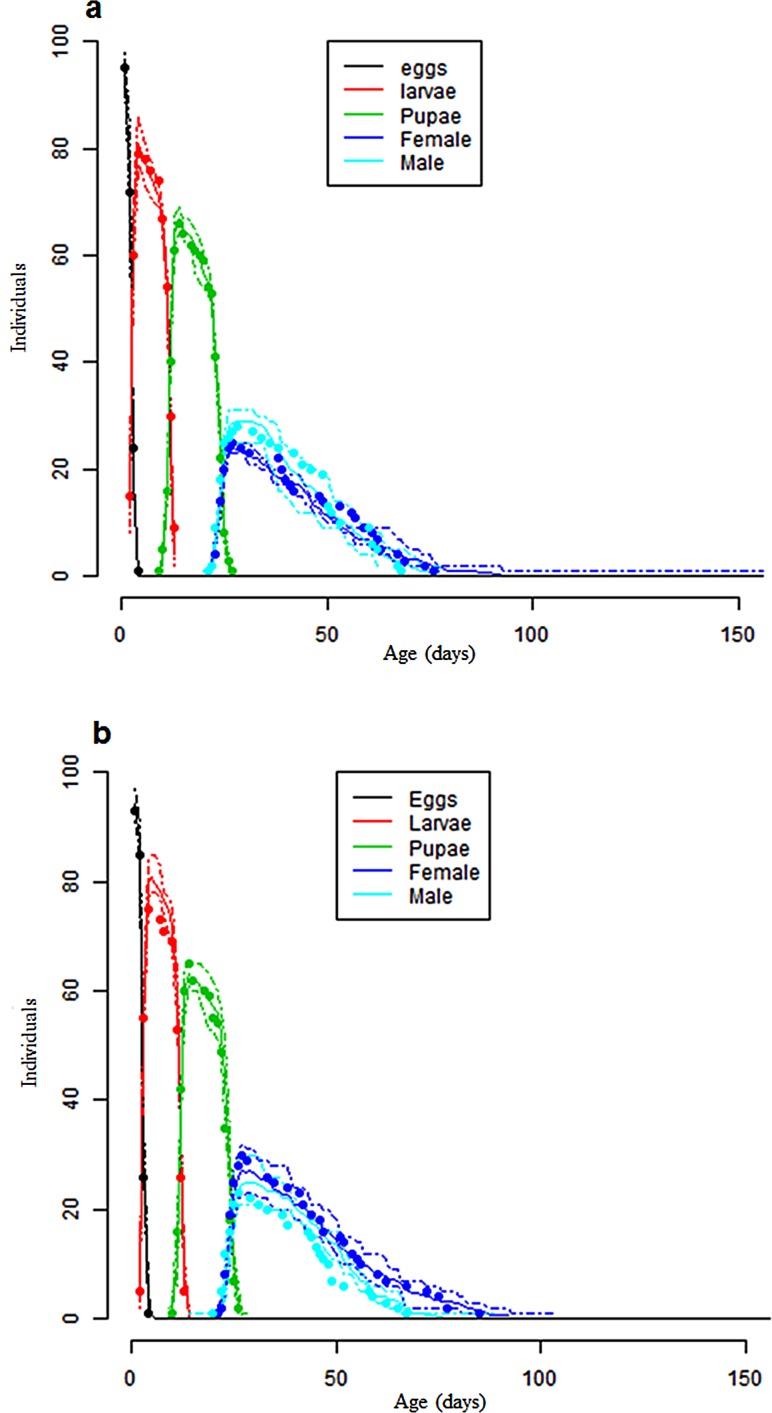
Model validation, observed and simulated life stage frequencies of C. rosa (6a) and C. quilicii (6b). Dots represent observed data points at fluctuating experiments, and the lines represent developmental frequencies simulated at fluctuated temepratures based on thermal reaction norms for constant temperatures. Solid lines are averages of the 50 simulations while the broken lines indicate minimum and maximum value obtained from the 50 simulations.